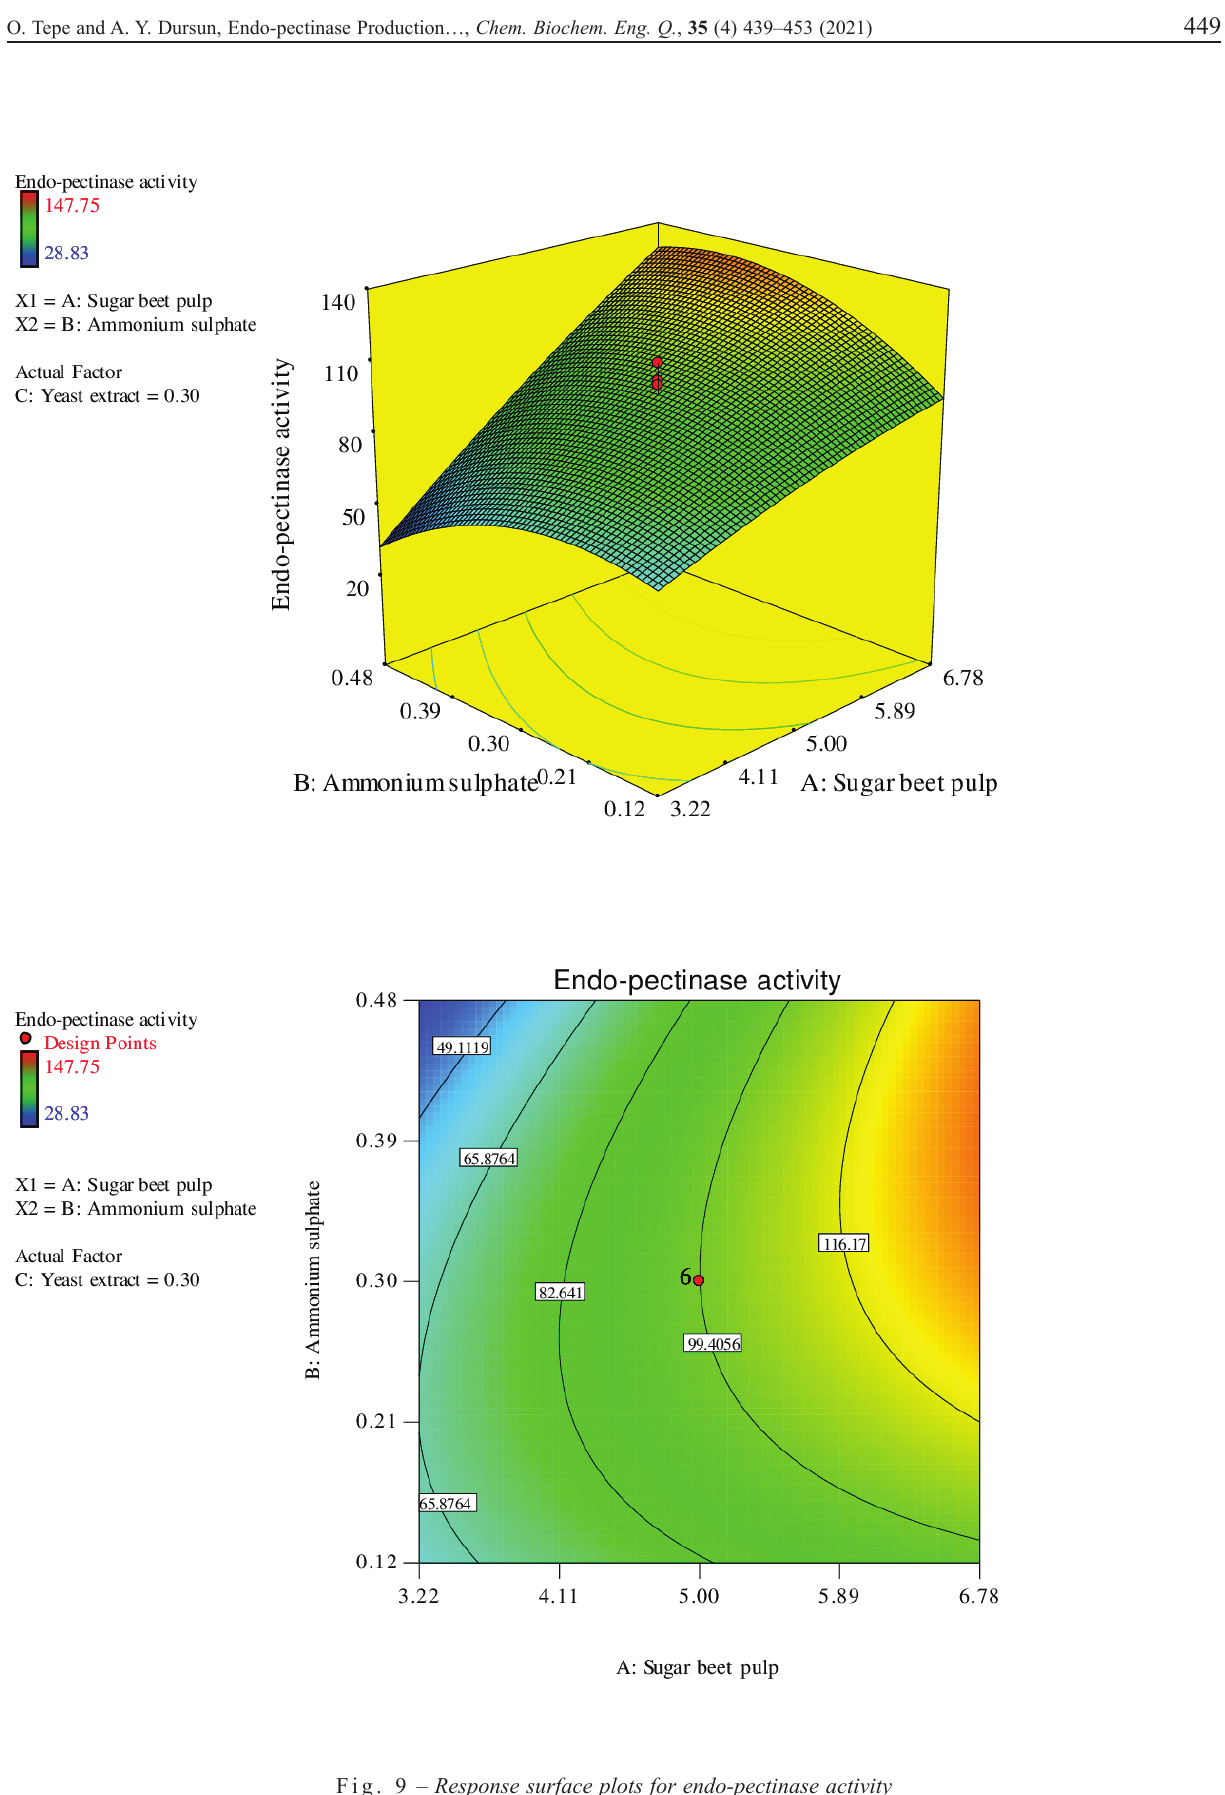
Fig. 9 – Response surface plots for endo-pectinase